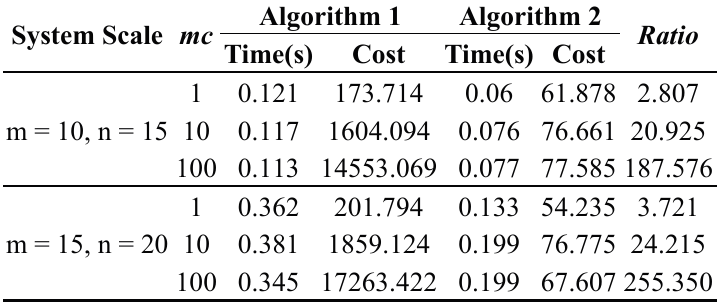
Table 2. Simulation result for the perfect test cases (N = 100, L = 5).